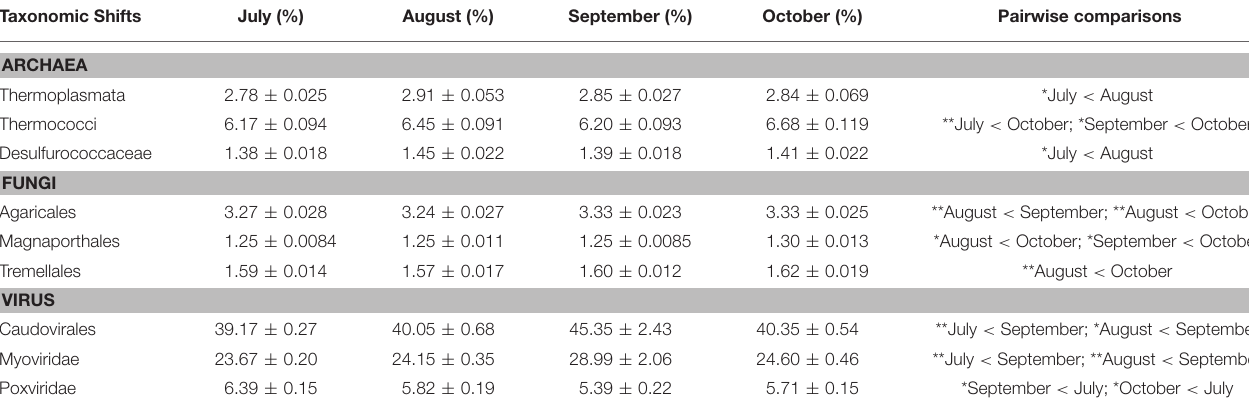
TABLE 2 | Statistically significant shifts in taxonomic groups across time in Siderastrea siderea metagenomes as measured by generalized linear mixed models with Tukey’s post-hoc test. Taxonomic